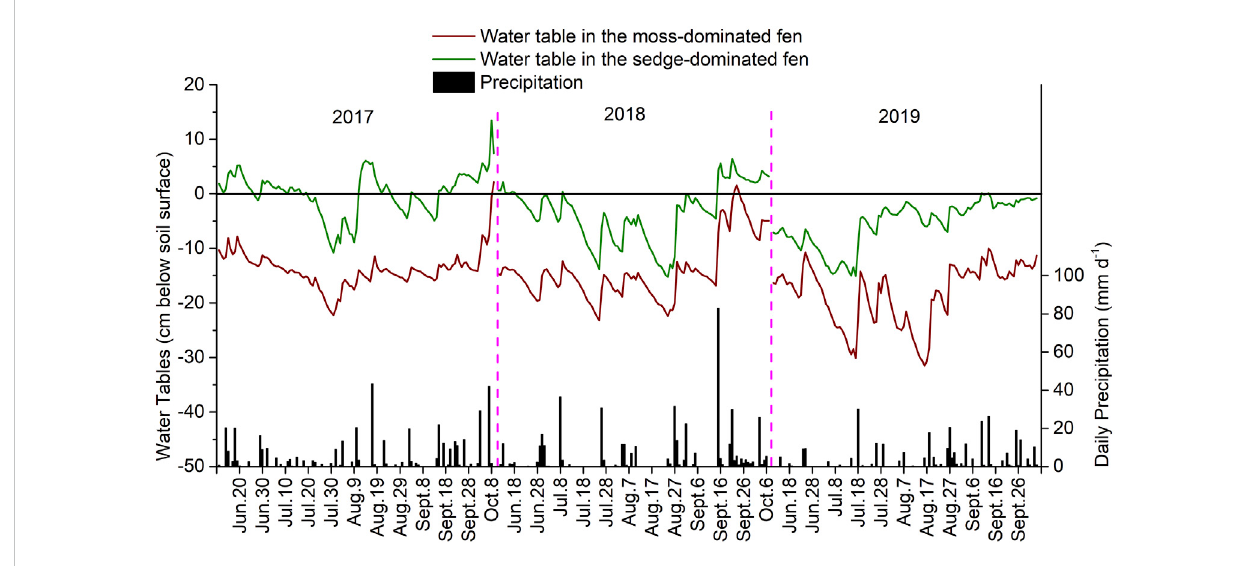
FIGURE 1 Water table levels and daily precipitation in the moss-dominated fen and the sedge-dominated fen over the experiment (2017 –